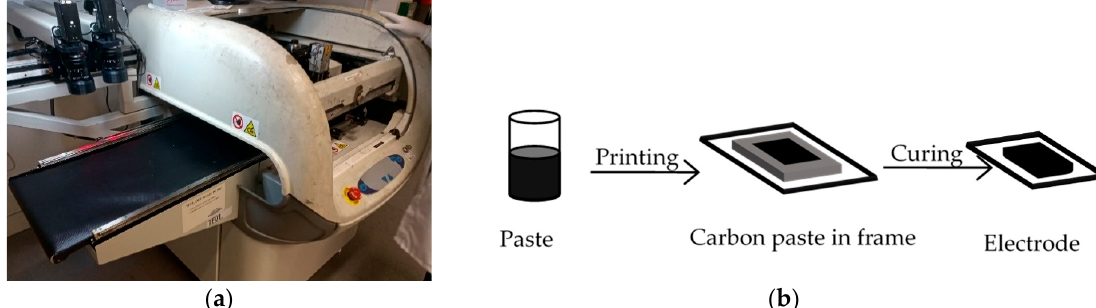
Figure 2. ( a ) The DEK 248 screen printer; ( b ) the schematic diagram for stencil